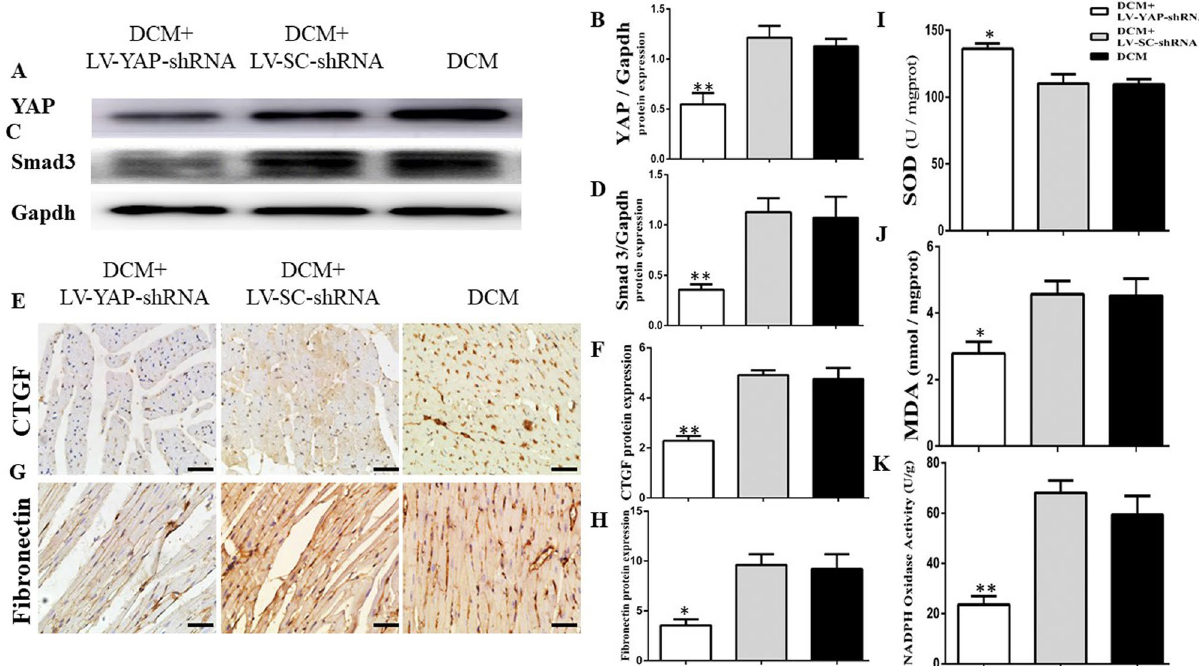
Figure 6. YAP, Smad3, CTGF and fibronectin expression in the 3 groups and SOD and, MDA levels and NADPH oxidase activity in the 3 groups. ( A ) YAP protein expression by Western blot. Figure ( A ) is cropped picture, omitting the repeated blots from the same group. The full-length blots/gel is complemented in supplementary figure 6. ( B ) Quantitative analysis of the results shown in ( A ). ( C ) Smad3 protein expression by Western blot. ( D ) Quantitative analysis of the results shown in ( C ). ( E ) Immunostaining of CTGF, ( F ) Quantitative analysis of the results shown in ( E ). ( G ) Immunostaining of fibronectin. ( H ) Quantitative analysis of the results shown in ( G ). ( I ) SOD levels in the 3 groups. ( J ) MDA levels in the 3 groups ( K ) NADPH oxidase activity in the DCM group, Ad-SC-shRNA group, and Ad-PRR-shRNA group. * p < 0.05, ** p < 0.01 compared with the DCM group (n = 11) and LV-SC-shRNA group (n = 11). Scale bar = 20 μm, magnification × 40. In this part, each group had n = 20 rats at beginning, in 2 weeks took 8 rats from each group for analysis. In 4 weeks after removing dead rats, the other of rats incorporate into analysis, in DCM group had 11 rats, LV-SC-shRNA group had 11 rats and LV-YAP-shRNA group had 12 rats finally.